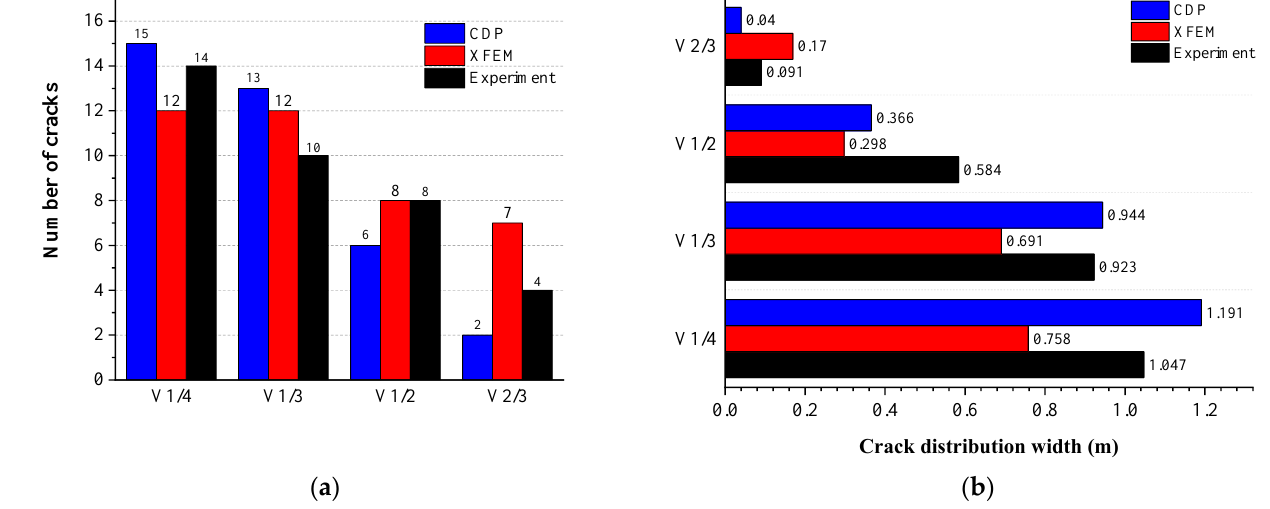
Figure 22. Crack behavior: ( a ) number of cracks and ( b ) distribution range of cracks.